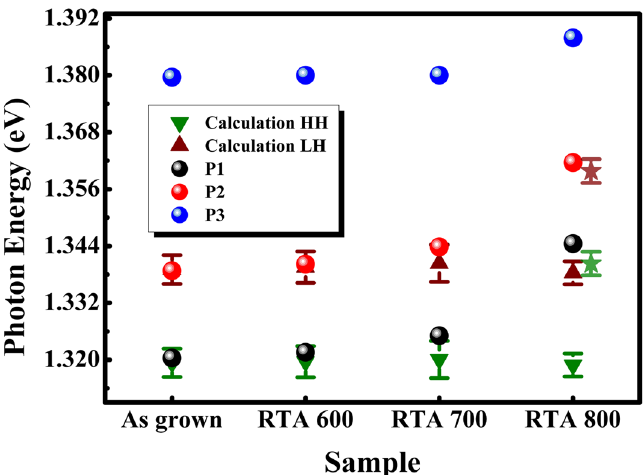
Figure 4. The evolution of P1, P2, P3 and the calculation results of HH and LH emission for different samples. The star symbols are calculation results for GaAs 0.932 Sb 0.068